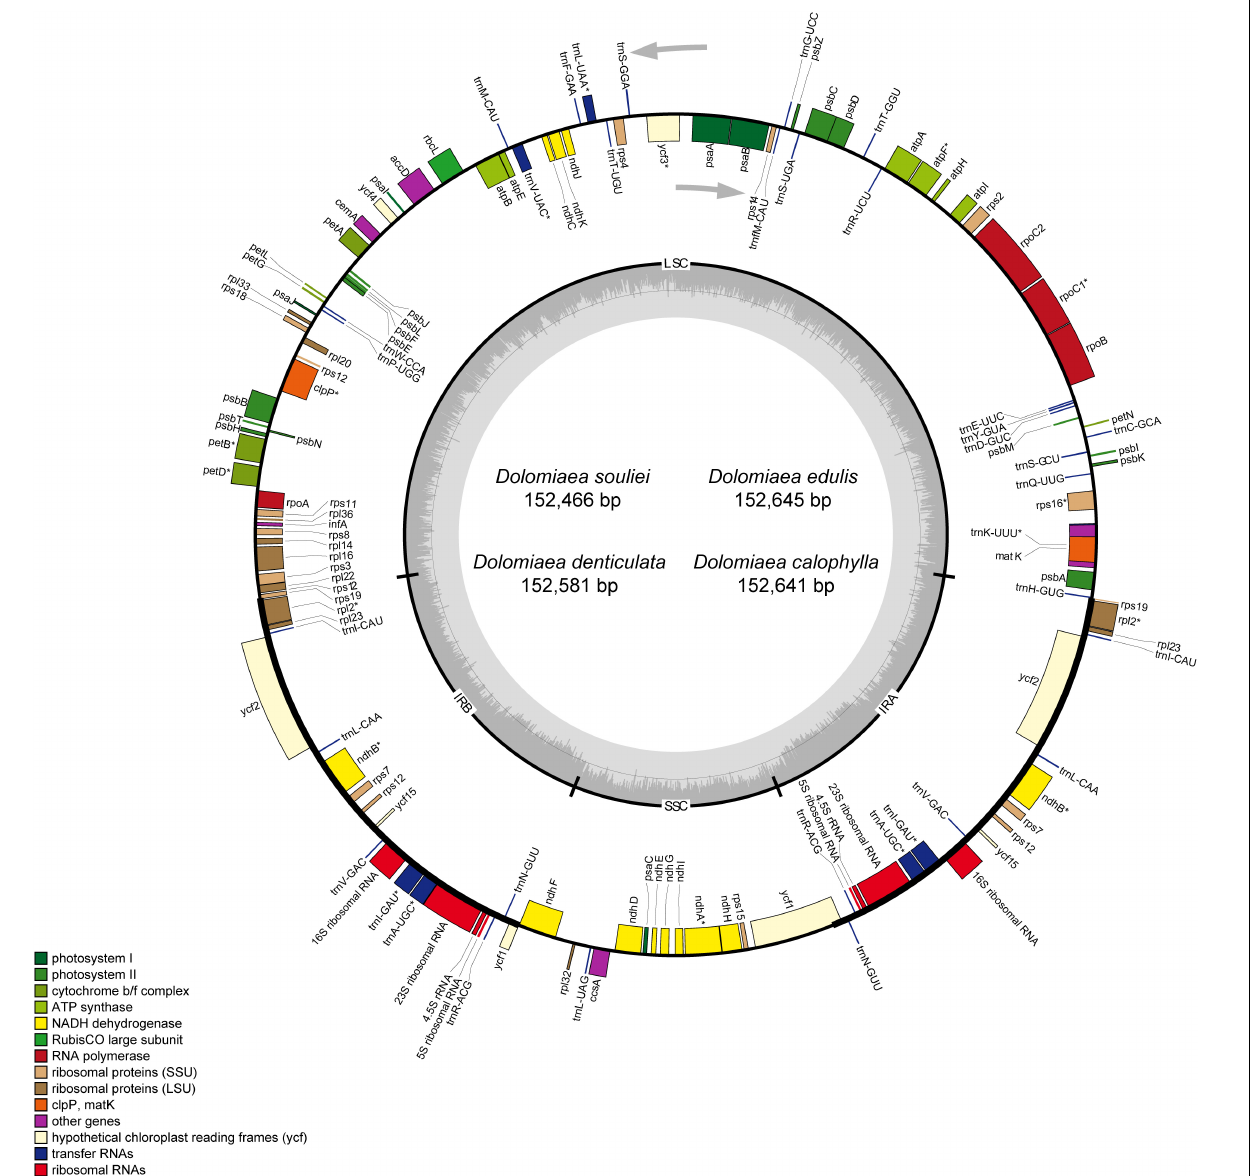
FIGURE 1 | Map of four newly sequenced plastomes of Dolomiaea . Genes outside the circle are transcribed in a counter-clockwise direction, whereas those inside the circle are transcribed in a clockwise direction. The dark gray area in the inner circle indicates GC content and the thick line shows the extent of different regions. Different colors for genes indicate different functional groups. LSC: large single copy; SSC: small single copy; IR: inverted repeat.